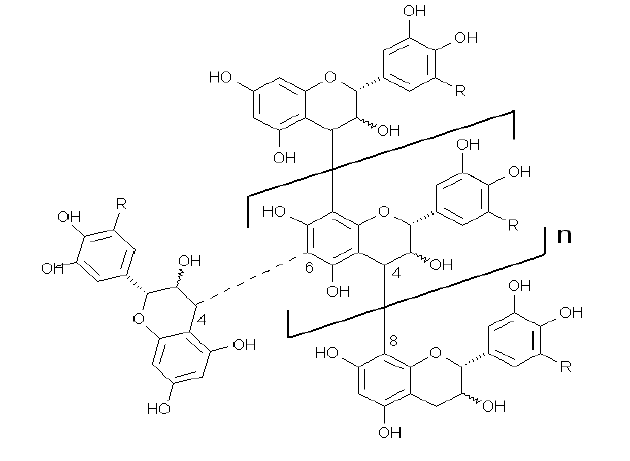
Figure 1. The chemical characteristics of condensed tannins; n indicates a monomeric unit; R indicates either H = procyanidins (PC) or OH = prodelphinidins (PD) as described by